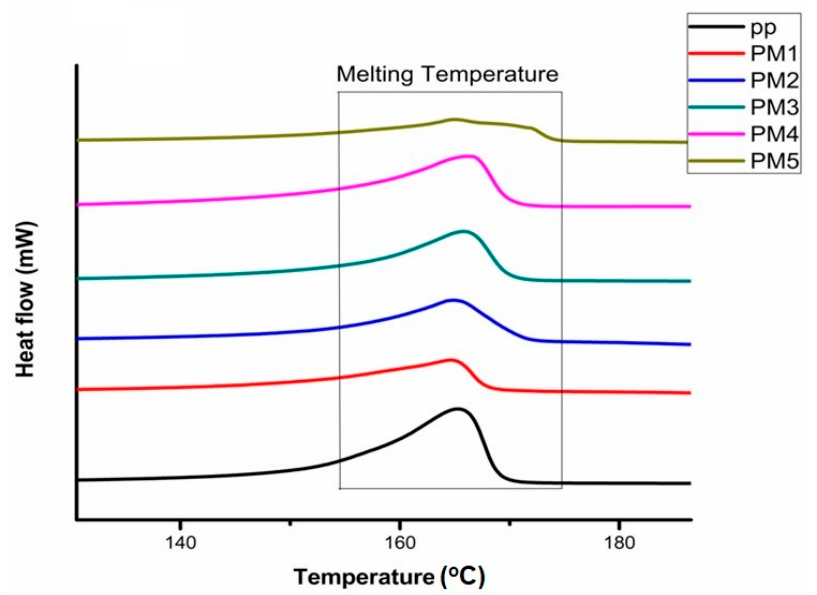
Figure 5. Differential scanning calorimetry (DSC) thermograms for MAH-grafted PP samples for varying MAH contents.